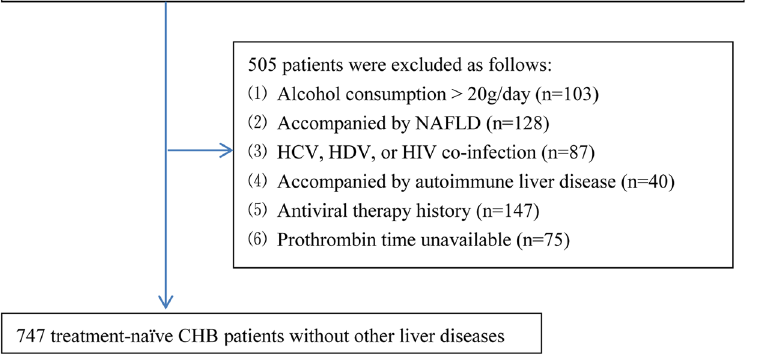
Figure 1. Flow diagram of the study population. CHB, chronic hepatitis B; NAFLD, non-alcoholic fatty liver disease; HCV, hepatitis C virus; HDV, hepatitis D virus; HIV, human immunodeficiency